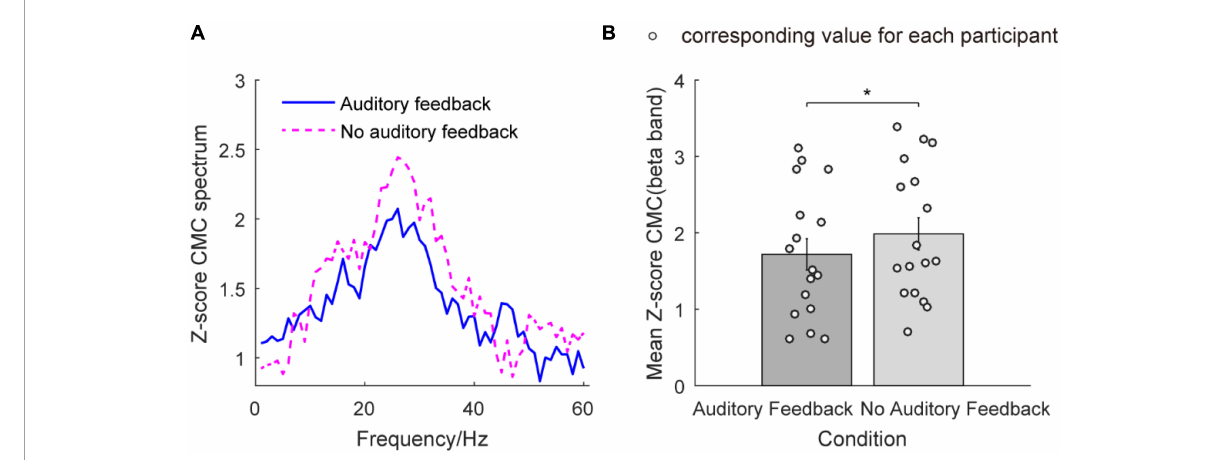
FIGURE7 The Z-score CMC from 1 to 60 Hz and mean Z-score CMC of the beta band in the auditory feedback condition and no auditory feedback condition in all the participants ( N = 17). (A) The Z-score CMC across 1–60 Hz in each condition type, the horizontal axis means frequency, and the vertical axis means the value of the Z-score CMC spectrum. The blue solid line means auditory feedback group, the magenta dashed line means no auditory feedback group. (B) The mean Z-score CMC of the beta band in each task, the horizontal axis means condition type, and the vertical axis means the value of mean Z-score CMC of the beta band. The empty circles mean the corresponding value for each participant. The data were presented as mean ± SEM. * p < 0.05. SEM, means standard error of mean; CMC, corticomuscular